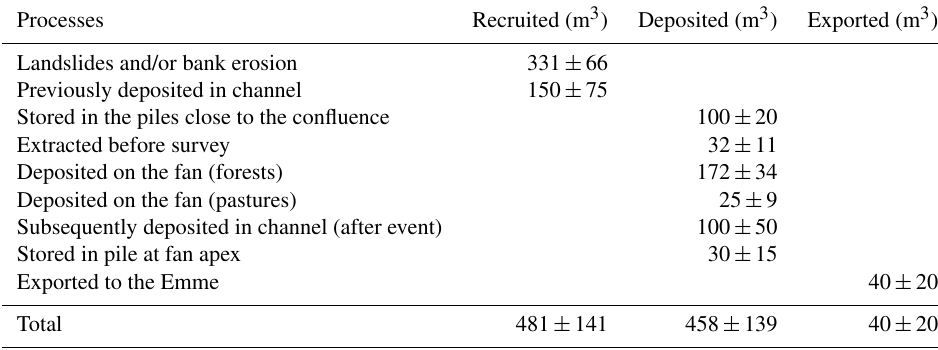
Table 4. Wood budget along the Sädelgrabe. Uncertainties are included in the stated volumes.